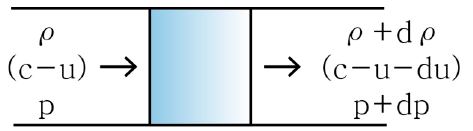
Figure 3. Control volume in the pipe to measure the injection rate.